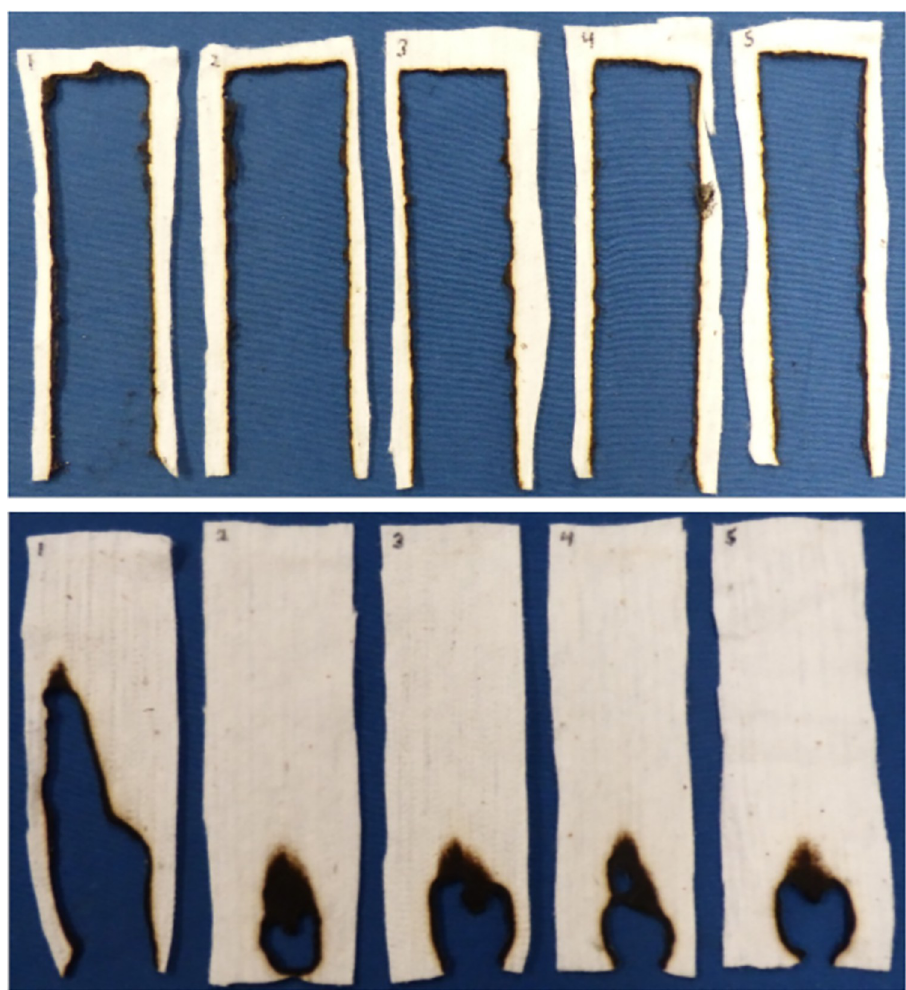
Fig 3. End point of five technical replicates of the 45˚ incline flame test of non-woven fabrics from the MAGIC RILs with the inferior HRC and the most superior HRC. Top series is fabric made from RIL-225, which like all untreated textiles produced from conventional cultivated white cottons, was fully consumed by flame in ~15s. Bottom series is RIL-385, which self-extinguished. See also Fig 2 and S1 and S2